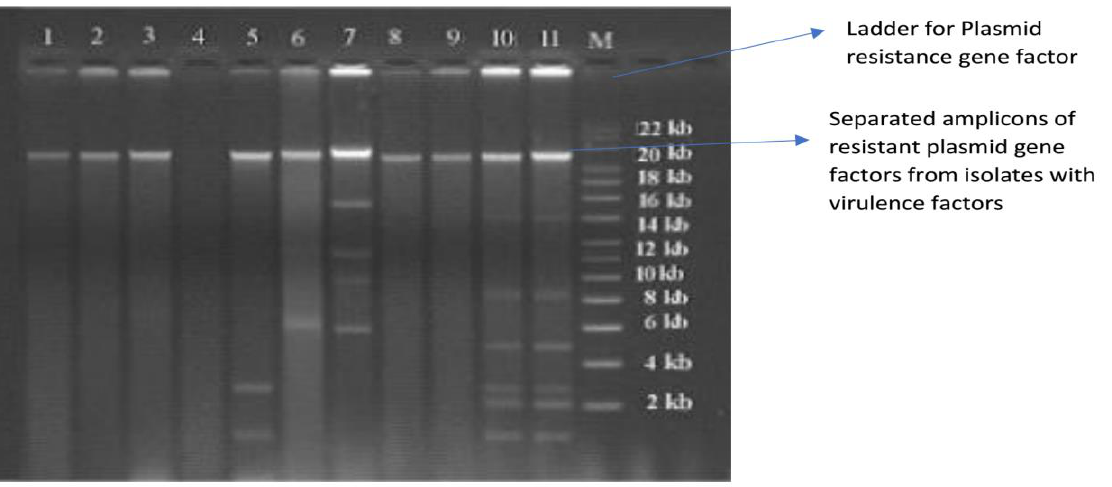
and 7) showing the presence of virulence genes stx 1 Lane M (100bp) = DNA size marker; Lane 1 = E. coli Lane K = Control, respectively. Plate 5. Electrophoretic gel plate of amplified gene for plasmid resistance factors in eleven of the E. coli isolates. (Note: Isolate 4 has no resistant plasmid encoded in it).